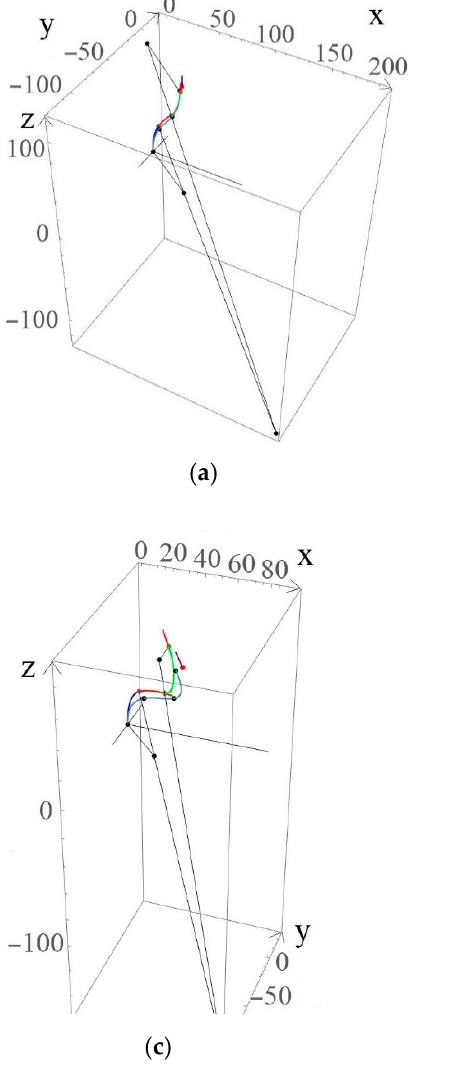
spine view when (cid:1833) = (0, 0, 100) and (cid:1815)(cid:3549) (cid:2928) = (0.254, 0.889, −0.381) .